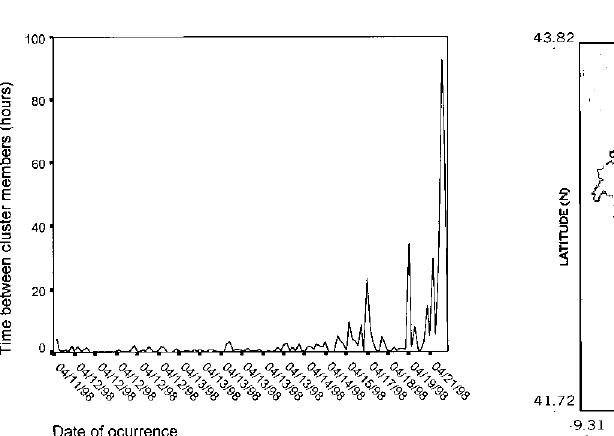
Fig. 13. Seismicity of Galicia in the period 1987- 2000.